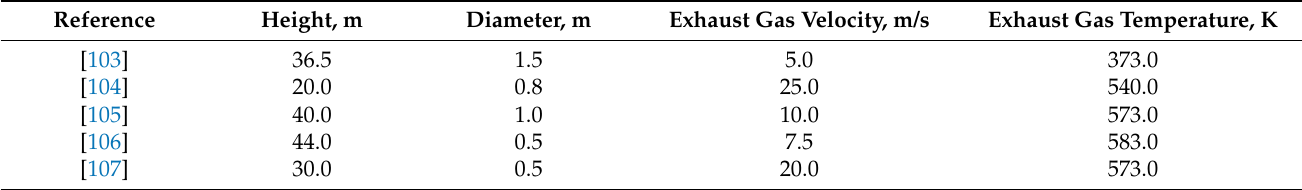
Table 2. Characteristics of the point emission sources integrated at CALPUFF